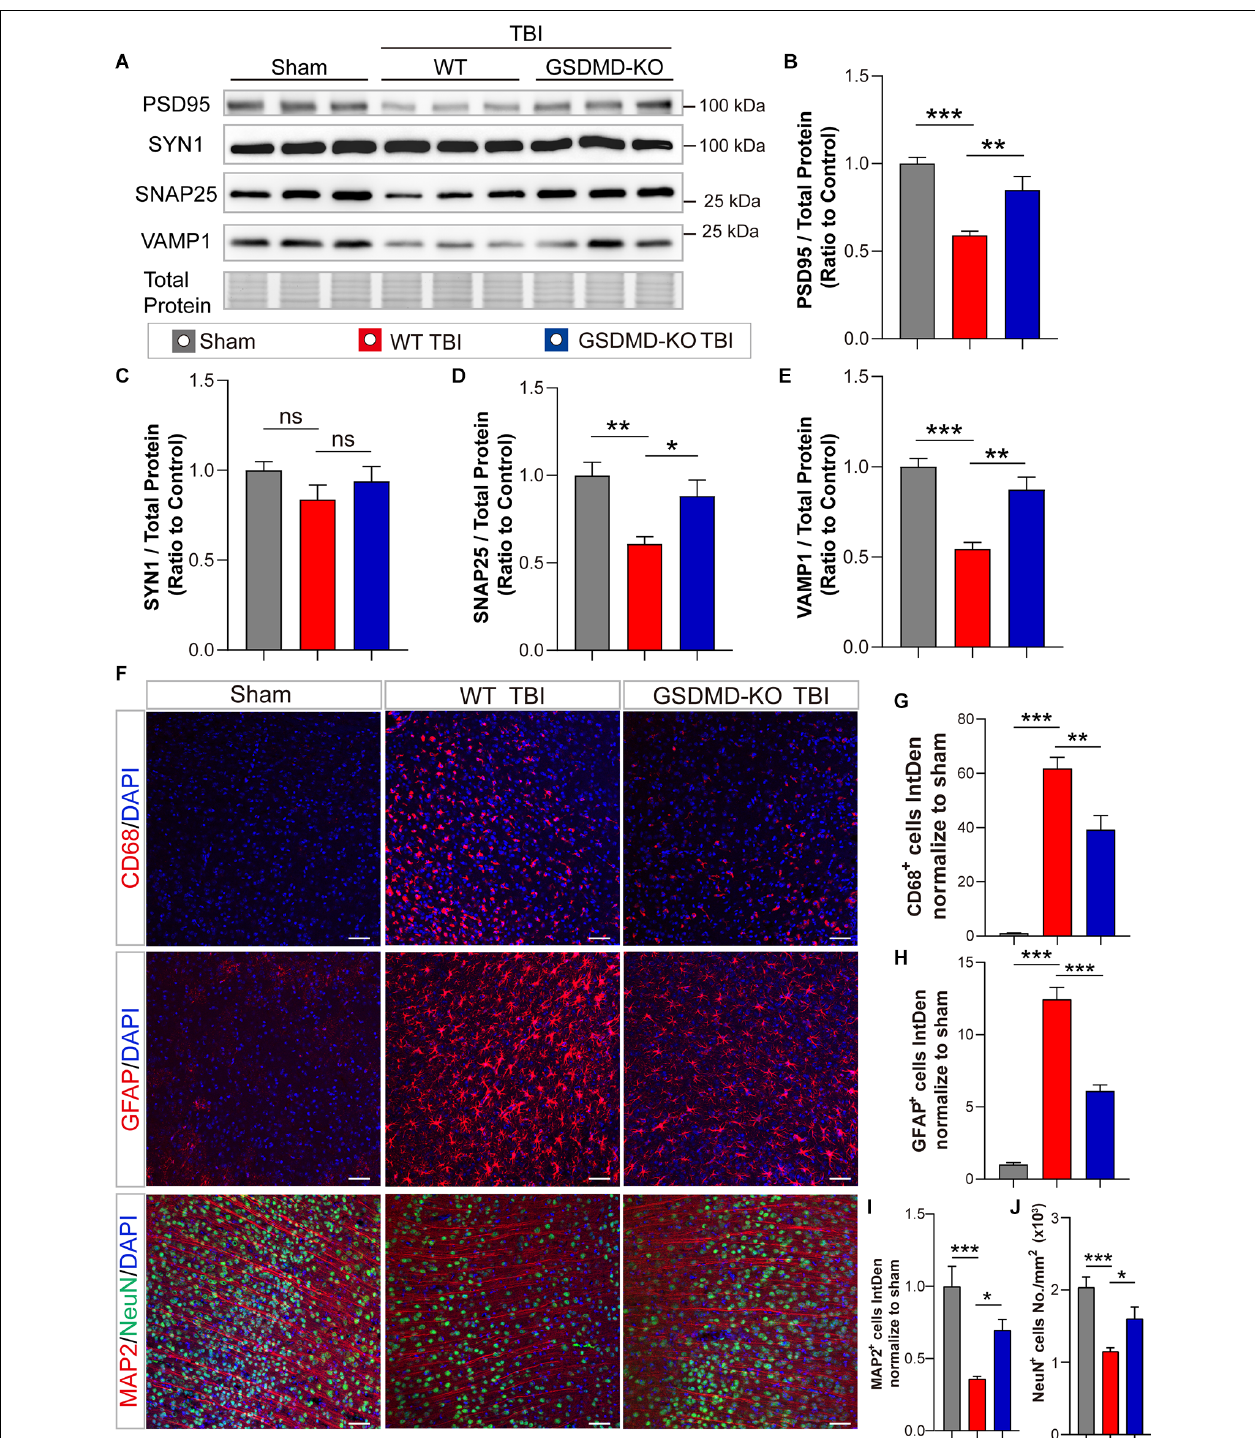
FIGURE 3 | GSDMD-KO mitigated neuropathological alterations in the peri-injury cortex at 3 days after TBI. (A) Representative images of immunoblots for synaptic proteins (PSD95, SYN1, SNAP25, and VAMP1) and total protein. (B–E) Quantitative analysis of synaptic proteins ( n = 6). (F) Representative immunofluorescence images of CD68, GFAP, MAP2, and NeuN in the peri-injury cortex after TBI or in the paired sham cortex. Scale bar = 50 µ m. (G–J) Quantitative analysis of integrated intensity of CD68 + , GFAP + , and MAP2 + cells and NeuN + cell number/mm 2 in the cortex (three slices from each brain and three brains were used for calculation). All data are presented as the mean ± SEM and were analyzed using one-way ANOVA followed by Tukey’s multiple comparisons test for significance. ns p > 0.05, * p < 0.05, ** p < 0.01, and *** p < 0.001.